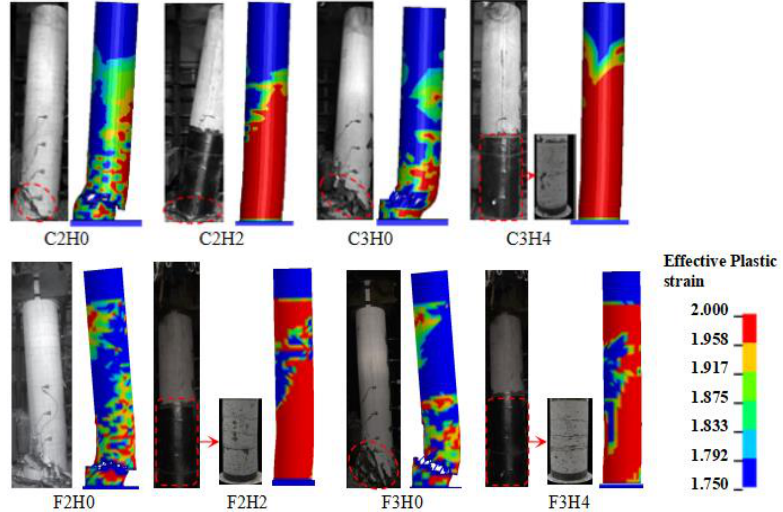
Figure 6. Comparison of final failure modes.